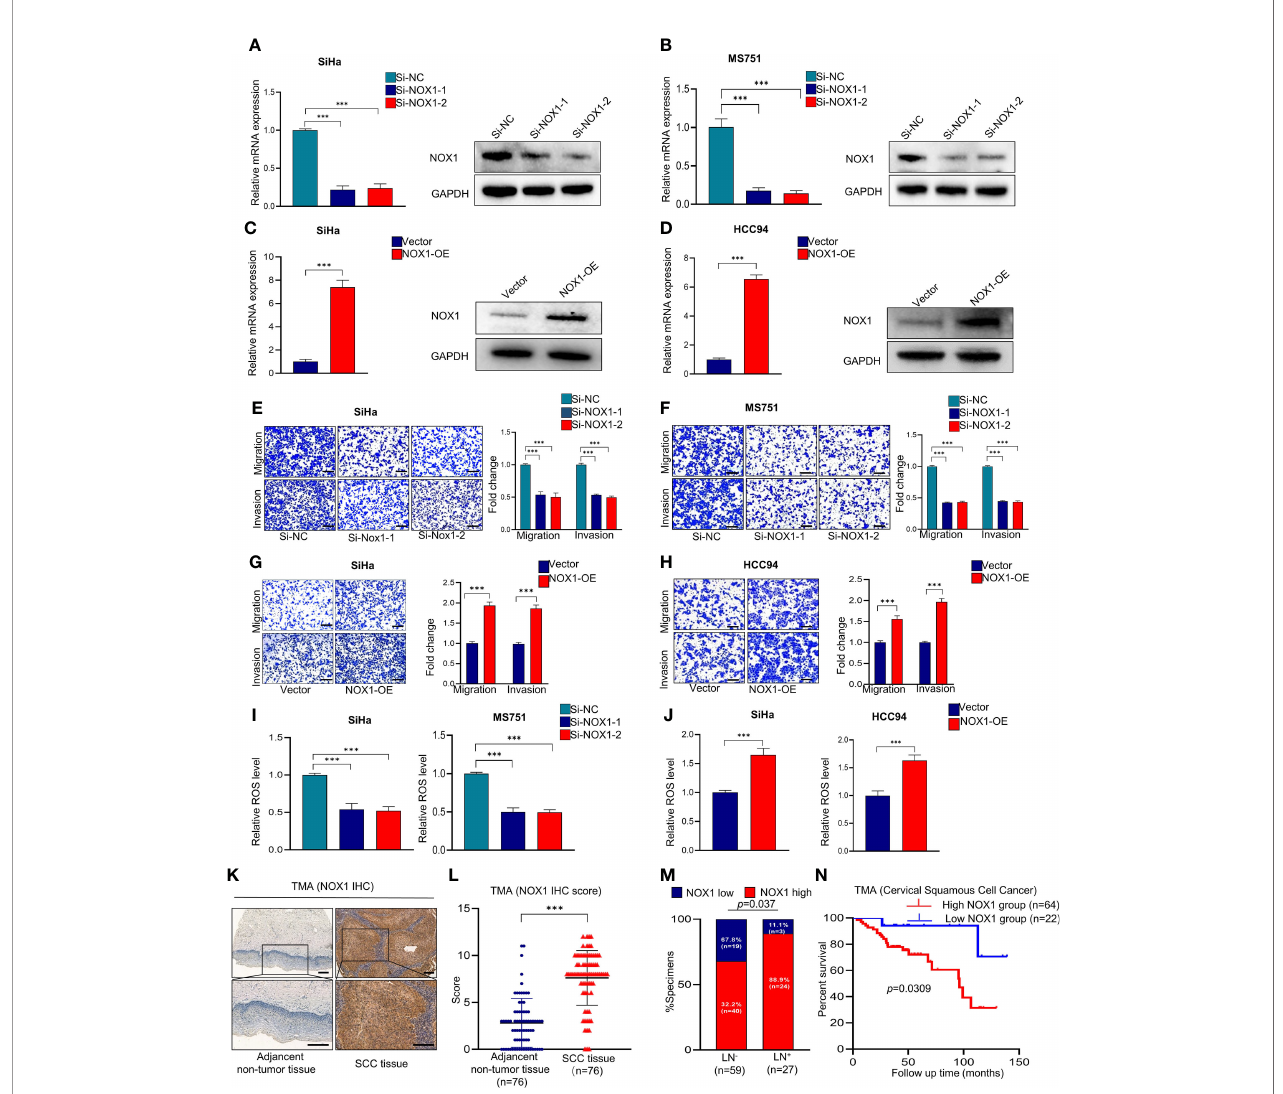
FIGURE 4 | NADPH oxidase 1 (NOX1) promotes metastasis and reactive oxygen species (ROS) production in cervical squamous cell carcinoma (CSCC) cells and may serve as a prognostic marker in CSCC patients. (A, B) qRT-PCR and Western blot were employed to evaluate the knockdown ef fi cacy of NOX1 in SiHa and MS751 (n = 3). (C, D) qRT-PCR and Western blot were employed to evaluate the overexpression ef fi cacy of NOX1 in SiHa and HCC94 (n = 3). (E, F) Cell migration assay and Matrigel invasion assay were employed to investigate the effects of NOX1 knockdown cells (SiHa and MS751) (scale bar: 200 m m). (G, H) Cell migration assay and Matrigel invasion assay were employed to investigate the effects of NOX1-overexpressing cells (SiHa and HCC94) (scale bar: 200 m m). (I) ROS level was reduced in NOX1 knockdown cells (SiHa and MS751). (J) ROS level was increased in NOX1-overexpressing cells (SiHa and HCC94) (n =3). (K) Representative images of the immunohistochemical (IHC) staining of NOX1 in human CSCC tissues and adjacent non-tumor tissues (scale bar: 200 m m). (L) Dot plots to show the IHC score of DDX19A expression using 76 pairs of CSCC tissues and adjacent non-tumor tissues tumor microarray (TMA) tissue sections ( p < 0.001). (M) Correlation between lymph node metastasis and DDX19A expression in CSCC patients. Chi-square test was used. (N) Kaplan – Meier analysis was performed for our CSCC patients ’ cohort to evaluate the association between DDX19A protein level and 86 CSCC patients ’ overall survival. Results represent three independent experiments (A – J) . The results were shown as mean ± SD, *** p < 0.001 by two-tailed Student ’ s